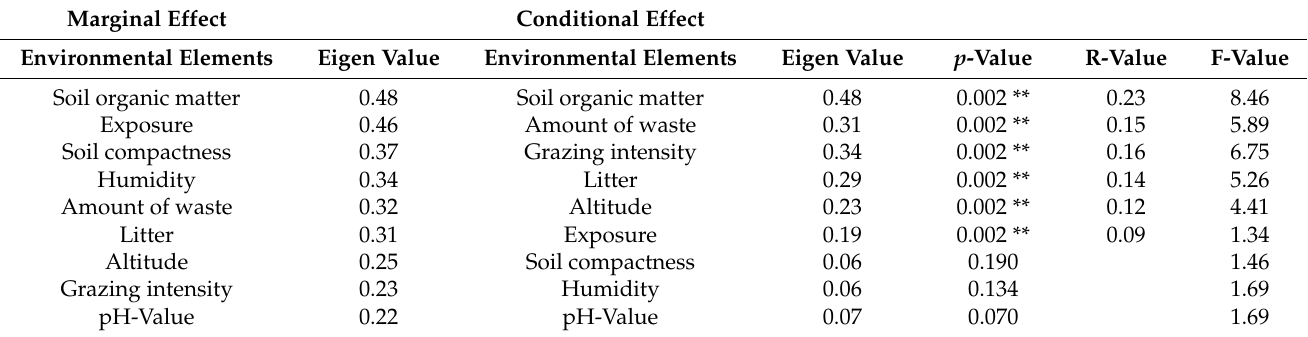
Table 3. Influence of environmental factors on the characteristics of plant community composition.